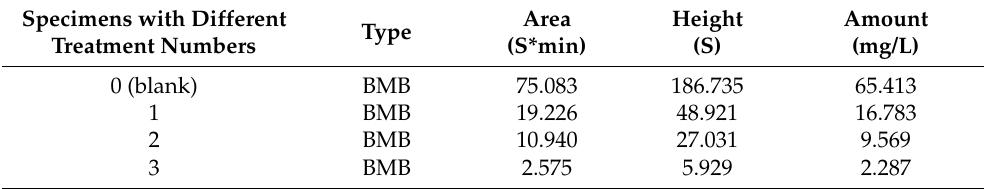
Table 1. The SO 42 − ion content of the specimens with different treatment numbers.